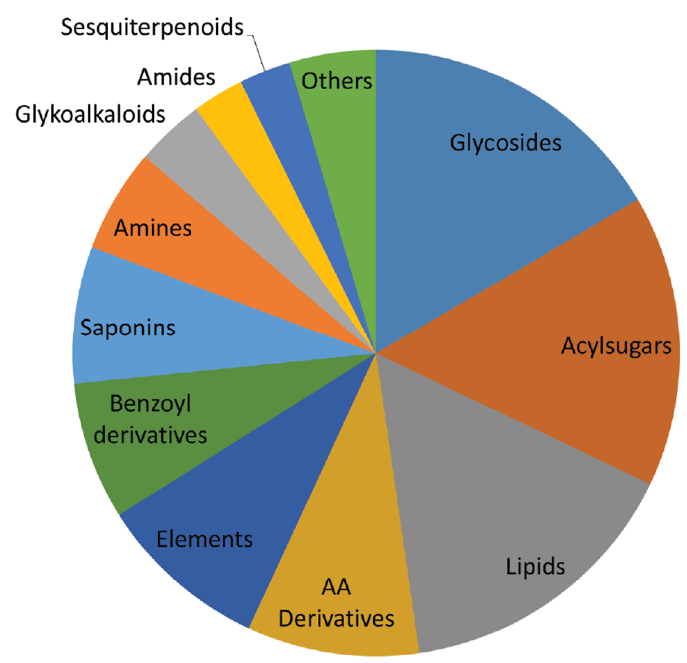
Figure 1. Pie chart of the classes of metabolites identified in rolD samples. The category “Others” includes lignans, phenylpropanoids, phytohormones, and nucleosides.